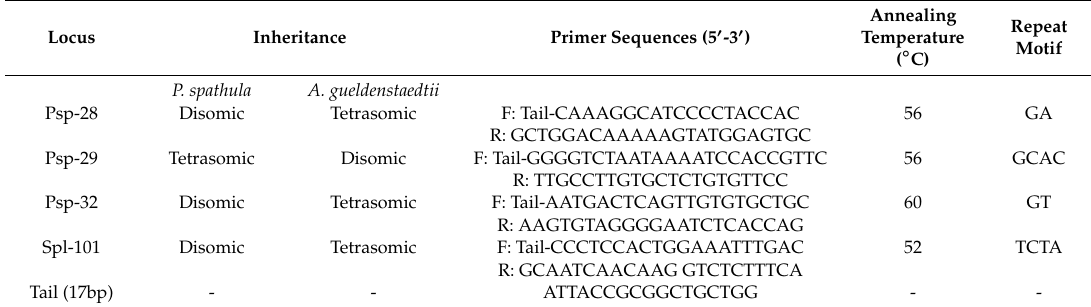
Table 2. Sequence and annealing temperature of microsatellite